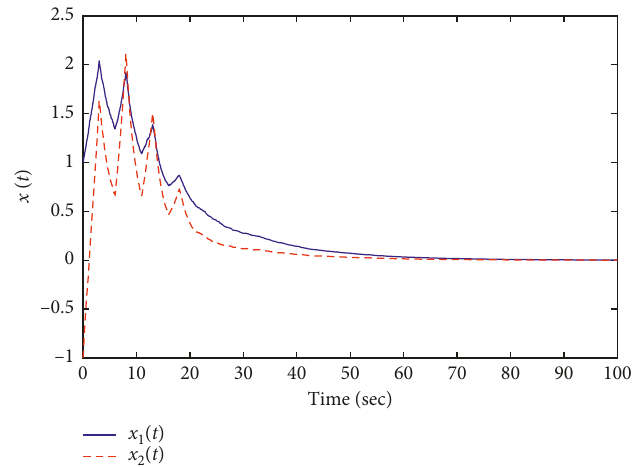
Figure 2: The system state responses under the controller solved by Theorem 2.